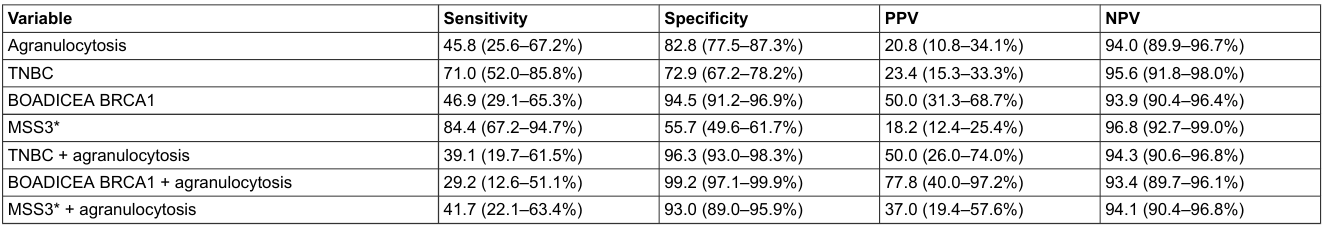
TNBC: triple-negative breast cancer; BOADICEA: Breast and Ovarian Analysis of Disease Incidence and Carrier Estimation Algorithm; MSS3: pathology-adjusted Manchester score; PPV: positive predictive value; NPV: negative predictive value * A threshold of 10% (≥15 points for MSS3) was used to calculate sensitivity, specificity, PPV, and NPV in this BC